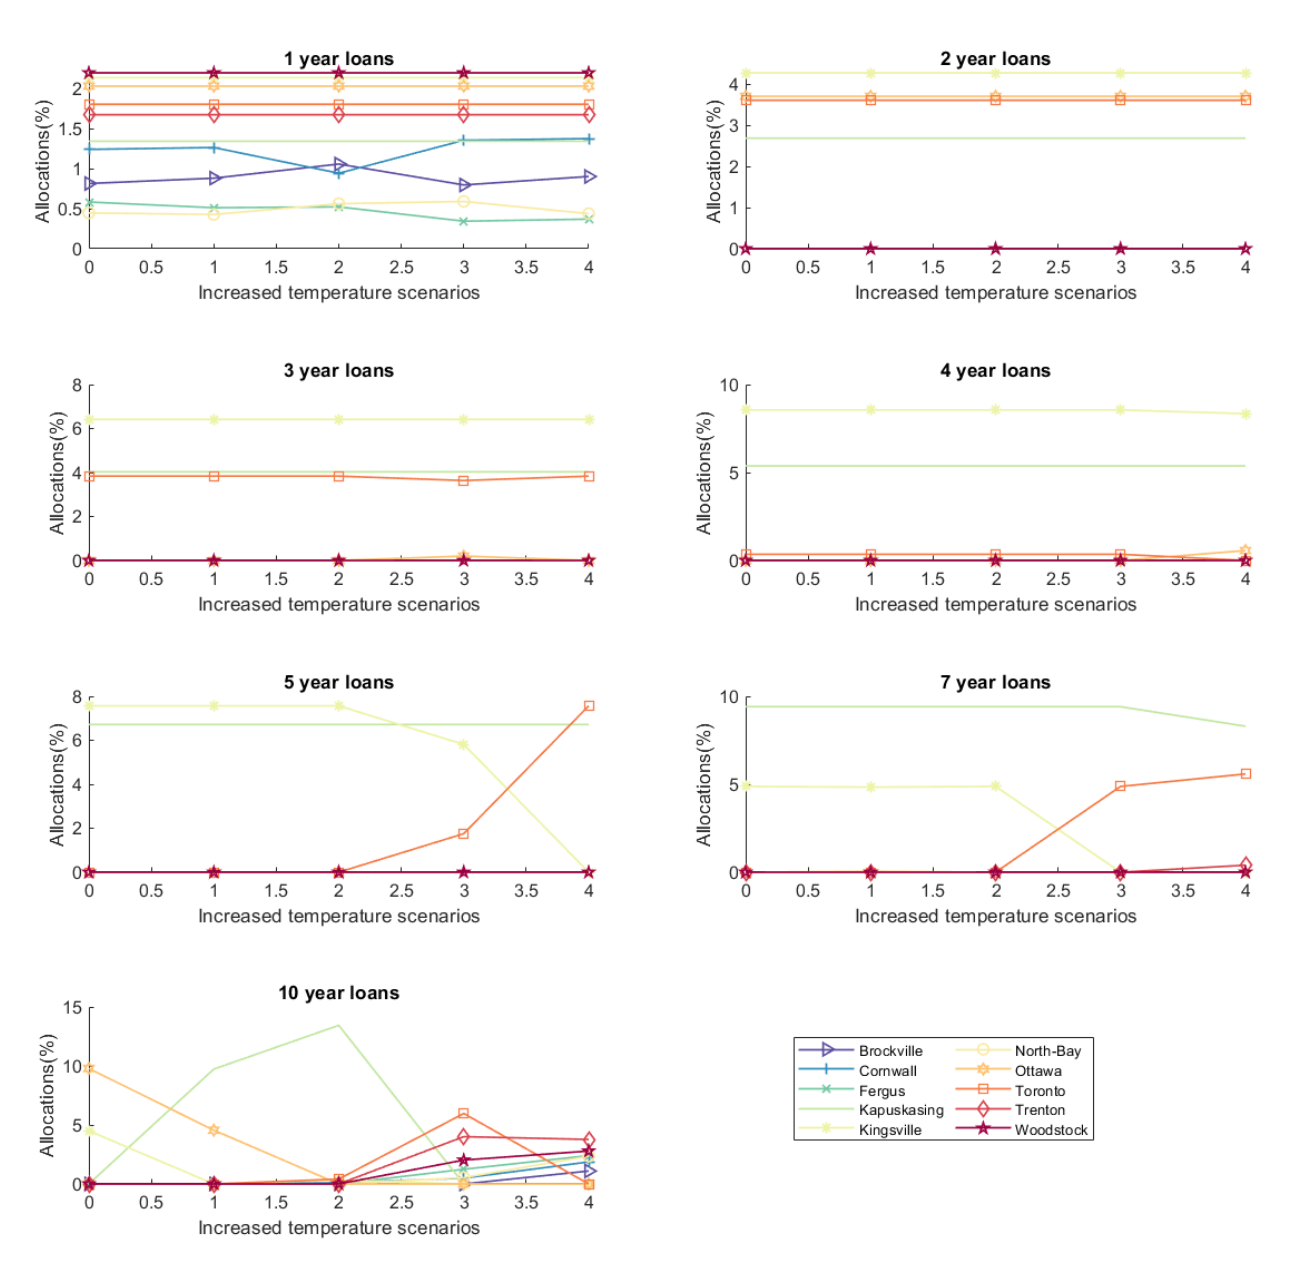
Figure 12. Allocations to each region when the entire budget is equally distributed among loans of all tenor under five different 1 ◦ C increased temperature